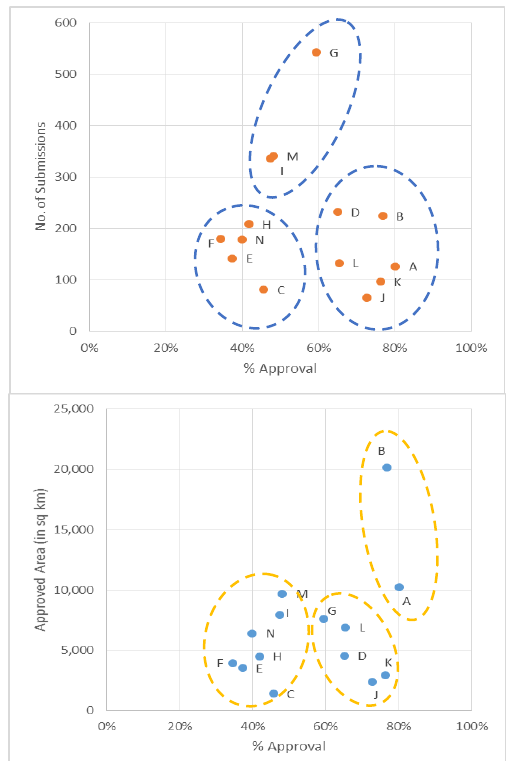
Figure 14. Scatterplot of Percentage Approval vs Number